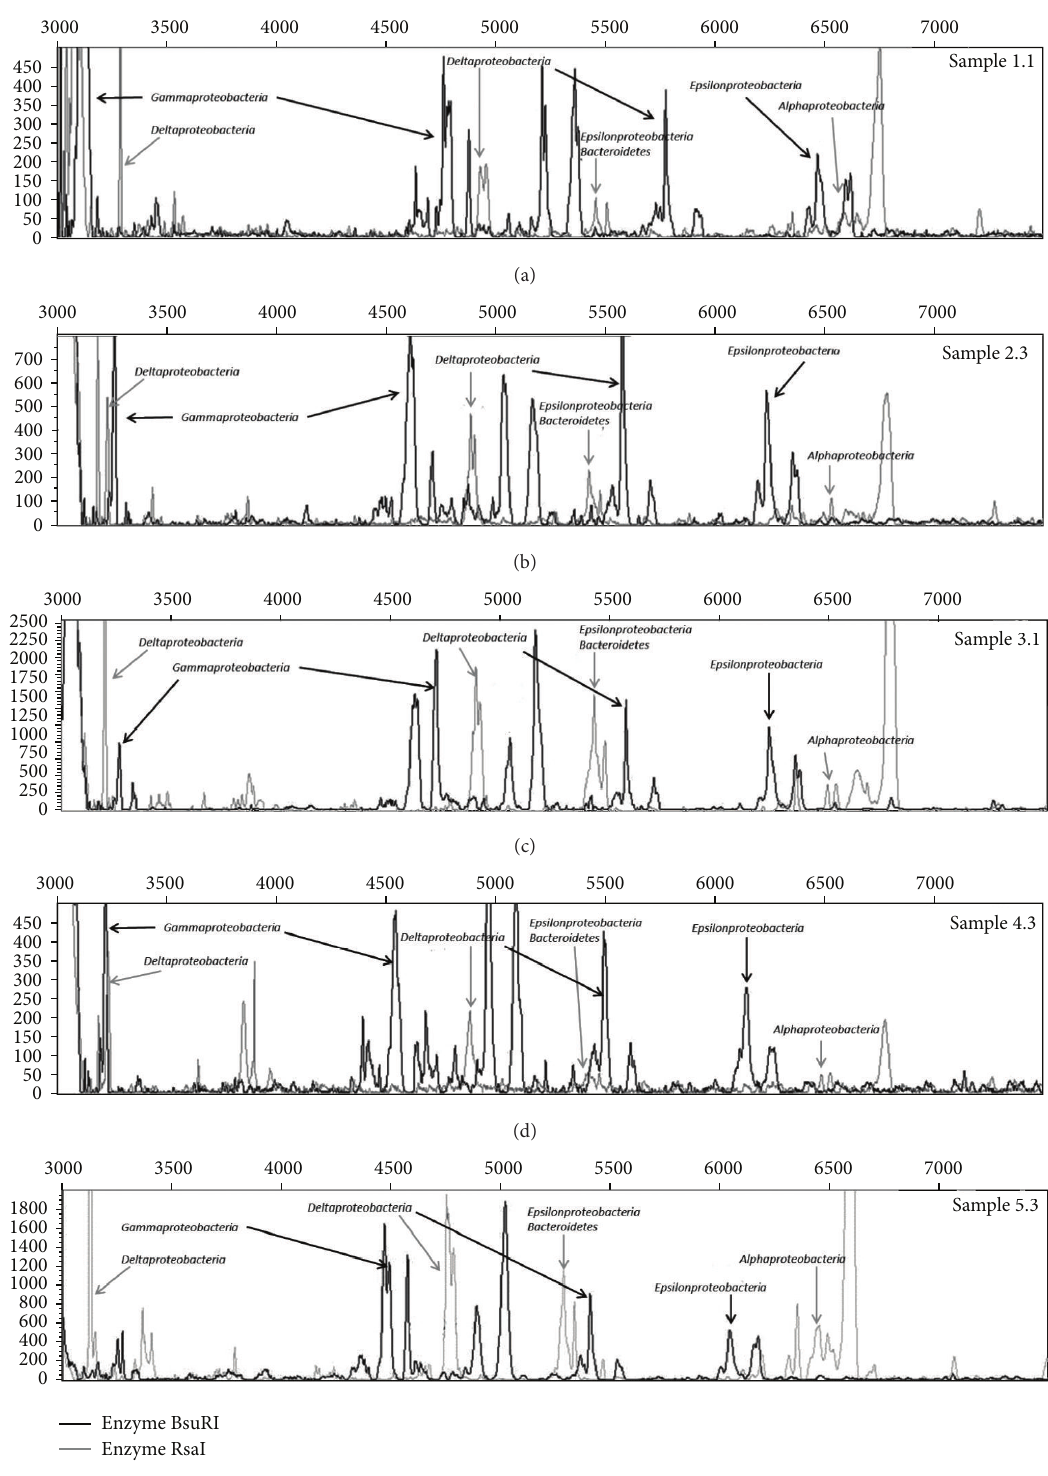
Figure 4: T-RFLP peak attribution after in silico